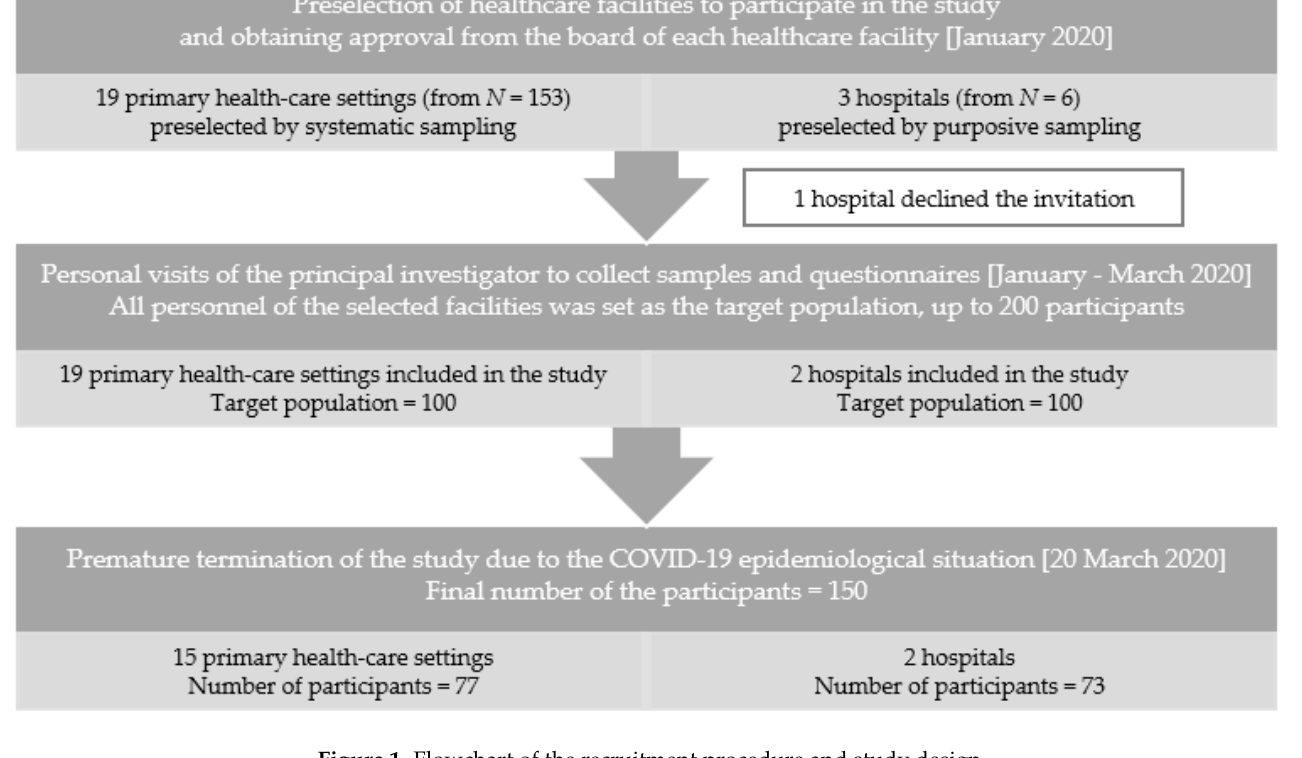
Figure 1. Flowchart of the recruitment procedure and study